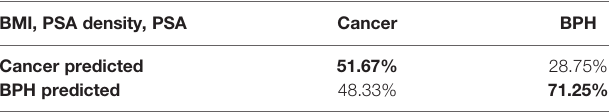
TABLE 9 | Confusion matrix of the most accurate sub-set of features excluding BIA parameters.